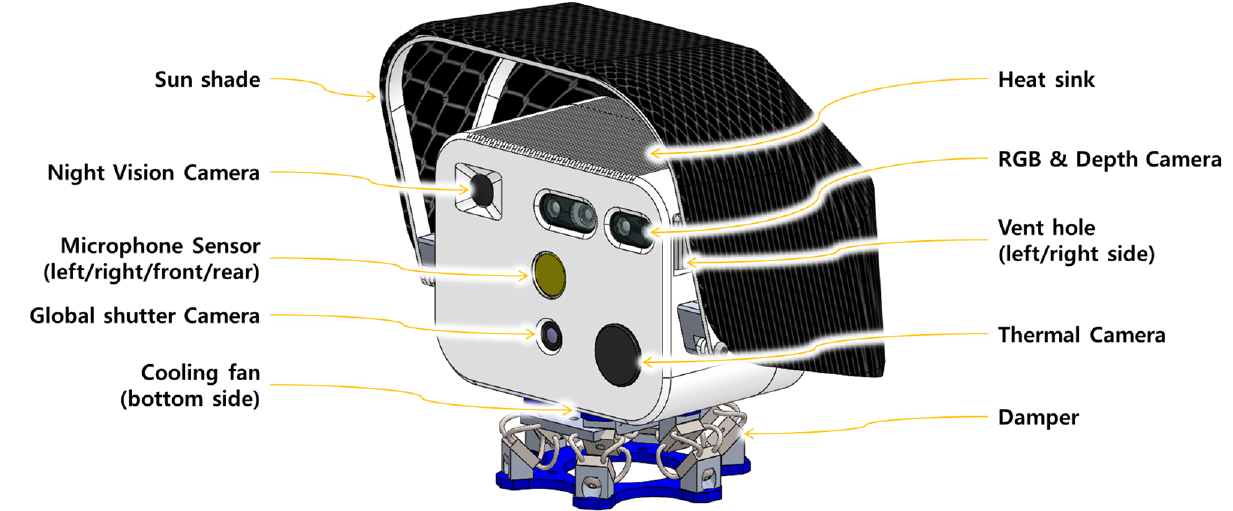
Figure 2. Multi-modal sensor system configuration.